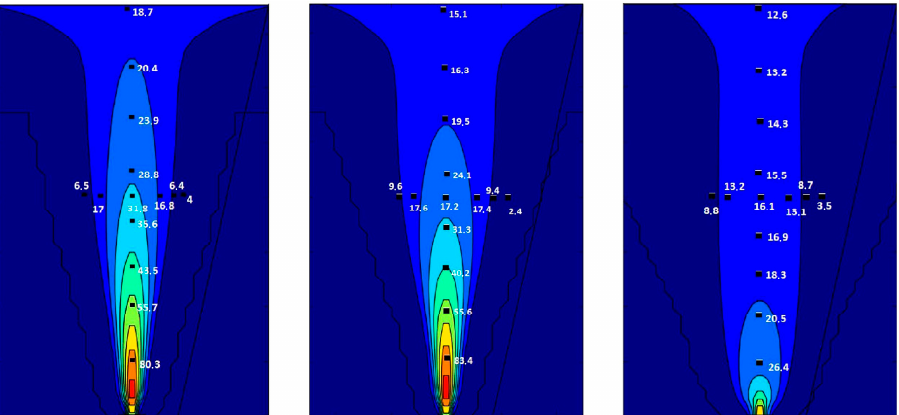
Figure 1. 2D plots showing impinging hydrogen-jet concentration predictions from three turbulent models (Standard, RNG, and Realizable k- ε ). Reproduced with permission [27]. Copyright 2019, Elsvier.